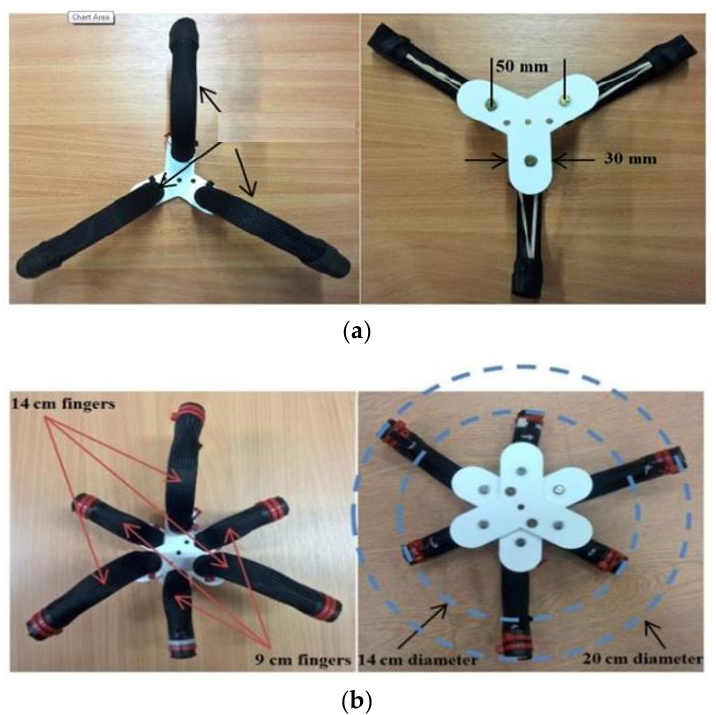
Figure 12. Three and six finger soft grippers using the SBCA [3]. ( a ) The three fingers soft gripper. ( b ) The two grasping-point rows, six fingers soft gripper.